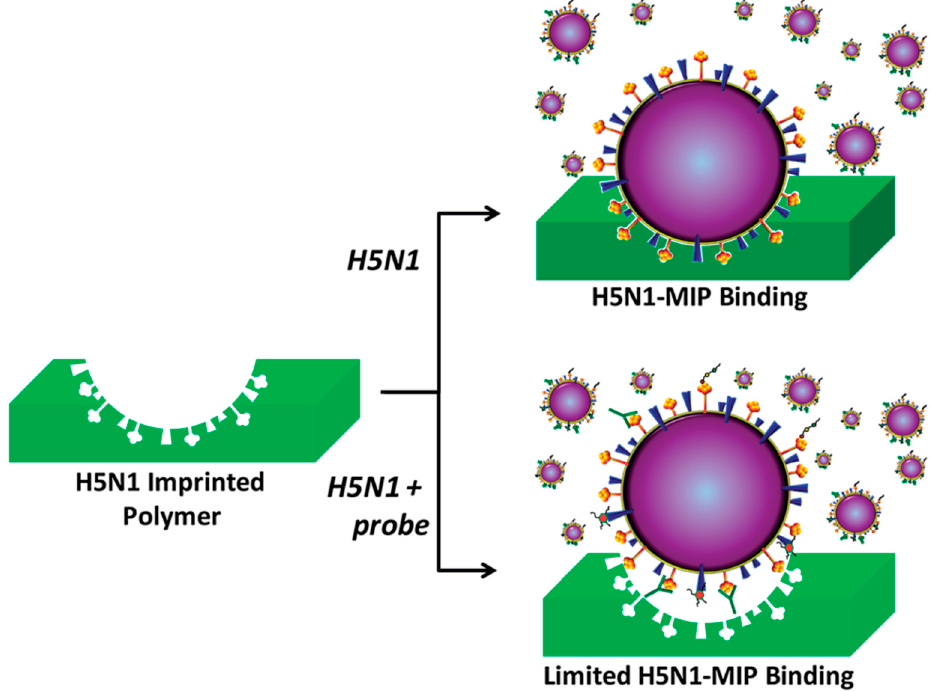
Figure 2. Schematic of H5N1 virus binding to a MIP ( top ) and inhibition of the process due to a conformational change in the H5N1-probe complex (Reproduced with permission from Reference [54]).